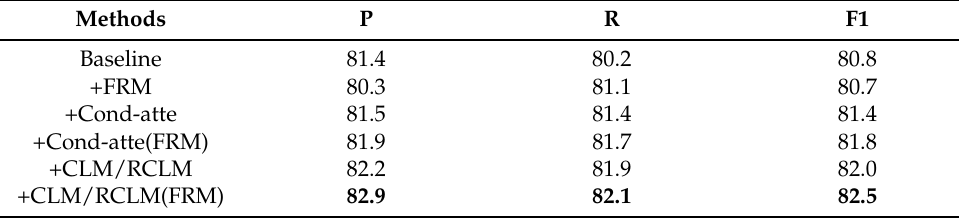
Table 3. The ablation study on TotalText.